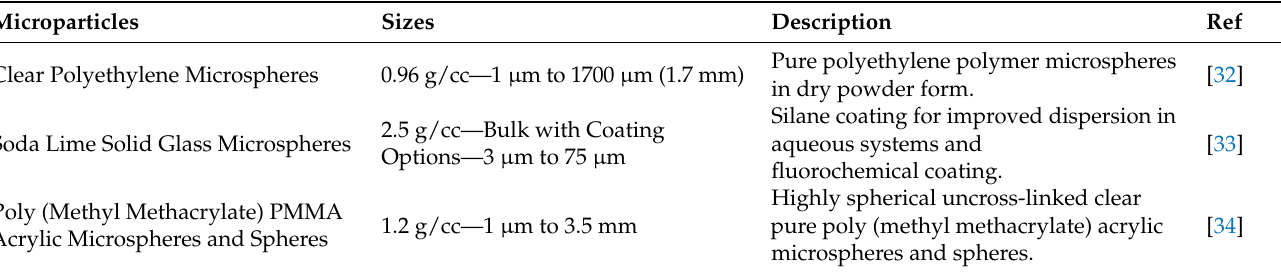
Table 11. Samples for